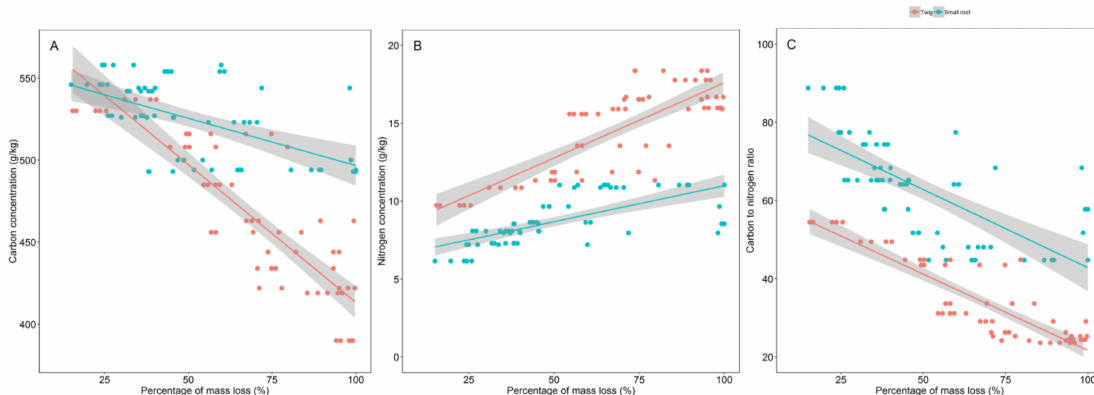
Figure 5. Relationship between percentage mass loss and ( A ) carbon concentration, ( B ) nitrogen concentration, and ( C ) carbon to nitrogen ratio for twigs (red dots) and small roots (blue dots) of Parashorea chinensis Wang Hsie over 1093 days in Mengla county, Xishuangbanna, China. Dots represent mass loss from each litter bag but chemical concentrations were analyzed from pool samples ( n = 5) of the litter bags harvested at each point in